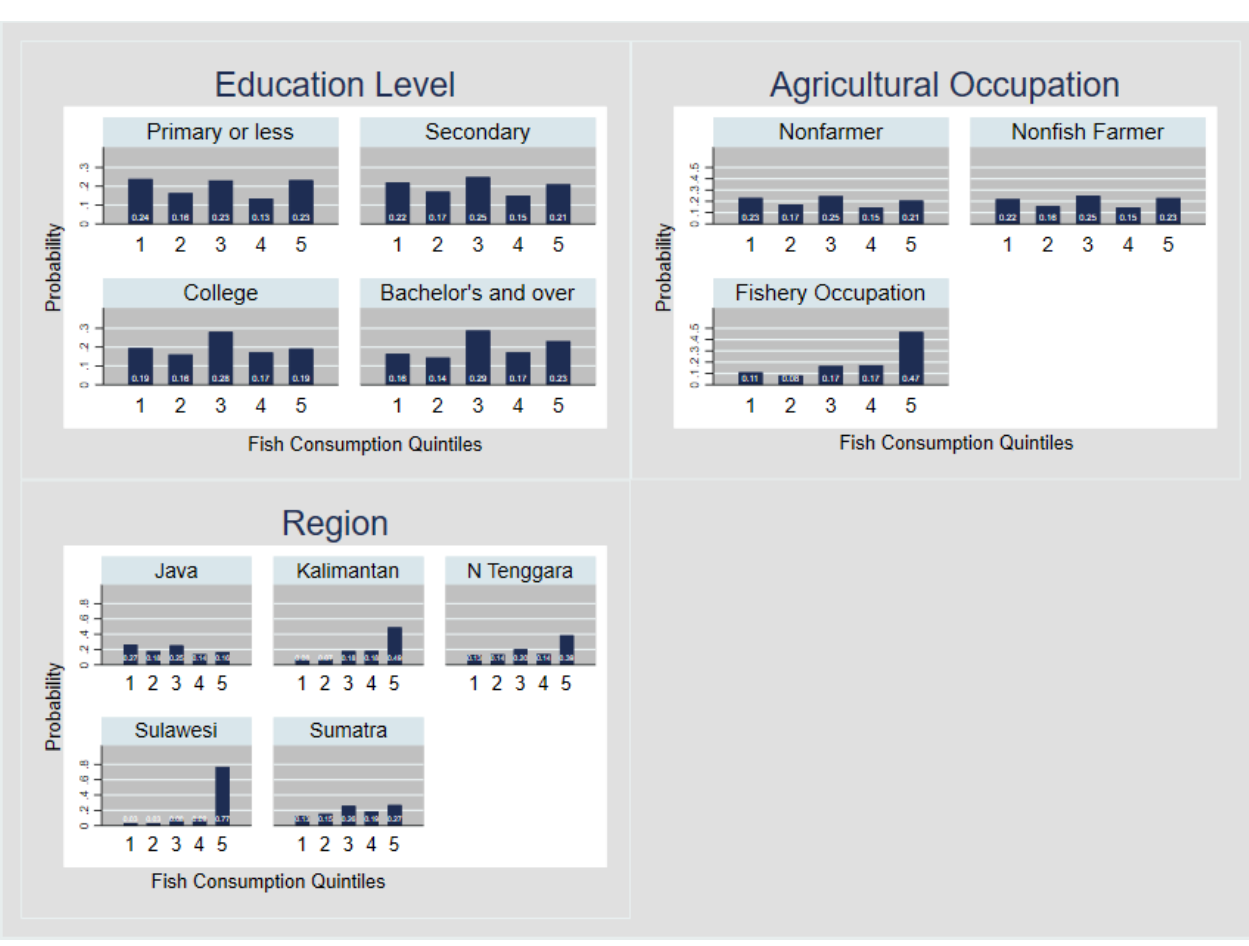
Figure 2. Bar charts showing the predicted probabilities of being in each fish consumption quintile by age-group, gender, marital status, and place of residence.